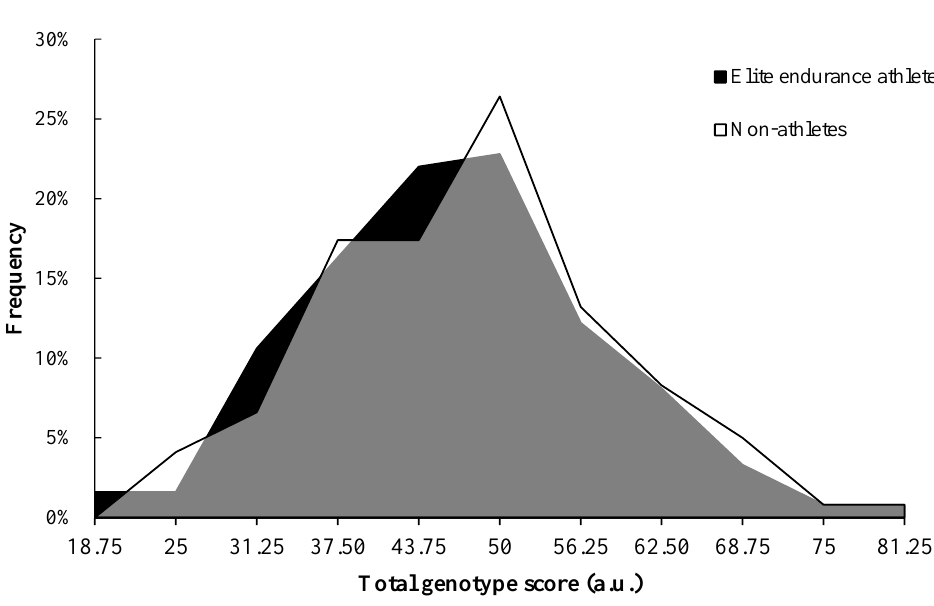
Figure 2. Frequency distribution of total genotype score in elite endurance athletes and controls. Lastly, there were no differences between the accumulative distribution of genotype scores between non-athletes and elite endurance athletes (Table 2; p = 0.692). Table 2. Accumulated percentage through the genotype scores (0–16 a.u.) in elite endurance athletes vs. non-athletes.